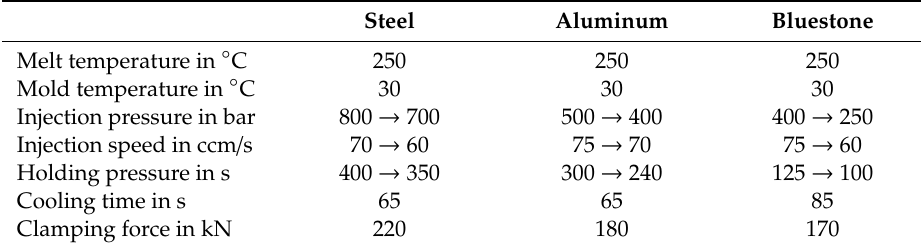
Table 6. Processing parameters after [53].